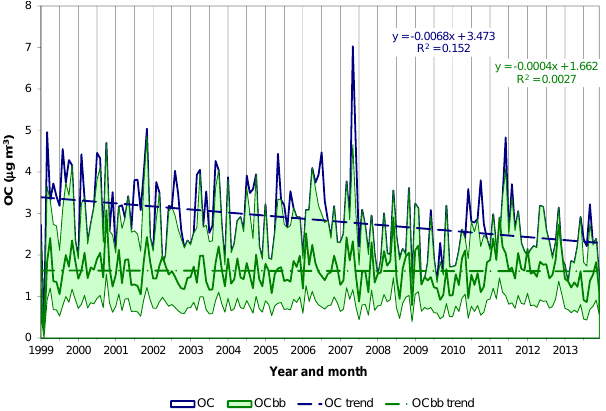
Figure 3. Monthly average measured OC (solid blue line) and com- puted biomass burning OCbb (solid green line with surrounding shaded area indicating estimated uncertainty) at CTR. Trends in OC (dashed blue line) are statistically significant ( p <0.05); trends in OCbb (dashed green line) are not statistically